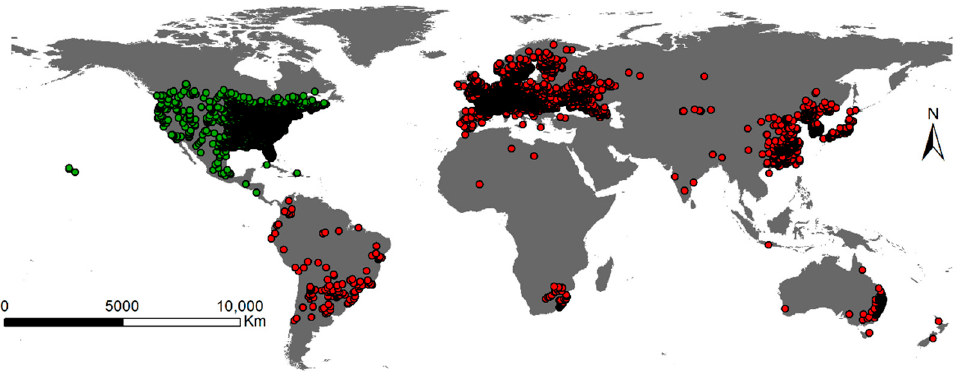
Figure 5. Records of native (green dots) and invasive (red dots) occurrences of Ambrosia artemisiifolia worldwide. The records of the occurrence of A. artemisiifolia were obtained from the Global Biodi- versity Information Facility (GBIF ) and the Chinese Virtual Herbarium (CVH).